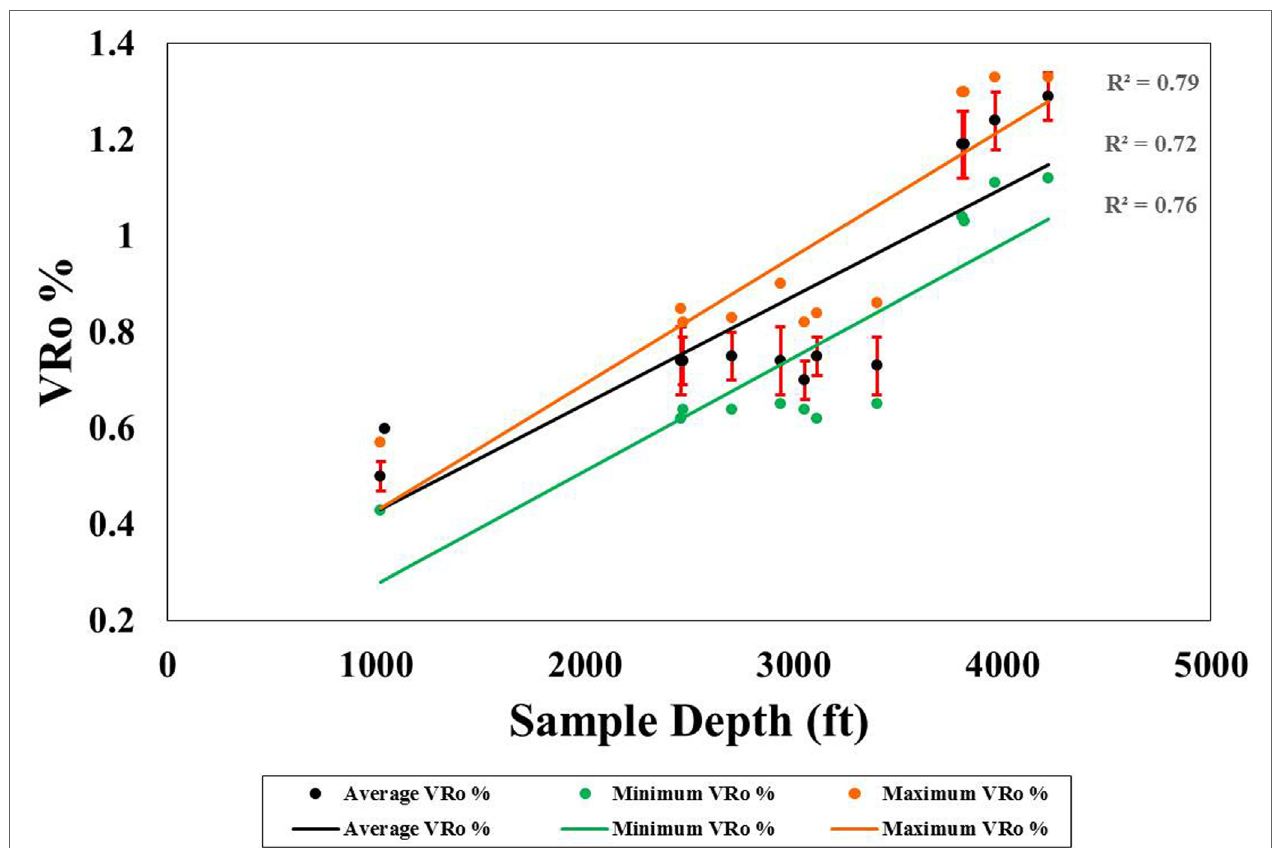
FigUre 1 | Linear correlations between the minimum (green), average (black), and maximum (orange) vitrinite reflectance values and the measured sample-depth ( R 2 = 0.71). The points representing the Interstate 2460 and Columbia 2471, and the EQT 3809 and 3818 wells overlap due to the proximity of the